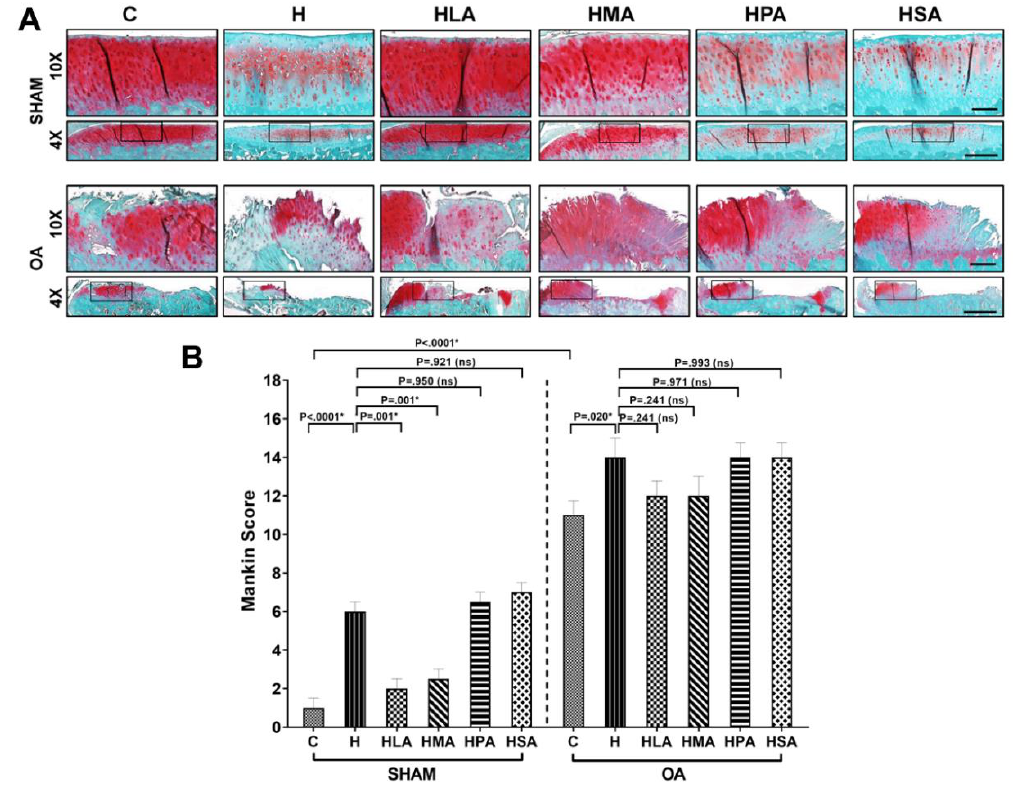
Figure 4. Histological evaluation of the knee joints. Pictures were obtained under 4× and 20× magnifications representing the medial tibial plateau. ( A ) Sections of articular cartilage stained with Safranin O/Fast Green shows the extent of proteoglycan loss among the different diet groups in both sham and osteoarthritic (OA) rats. (B) The severity of articular cartilage degradation was graded using Mankin scoring system in both sham and OA rats. All values are represented as mean ± SD, n = 6. C, corn starch diet-fed rats; H, high-carbohydrate high-fat diet-fed rats; HLA, high-carbohydrate high-lauric acid diet-fed rats; HMA, high-carbohydrate high-myristic acid diet-fed rats; HPA, high-carbohydrate high-palmitic acid diet-fed rats; HSA, high-carbohydrate high-stearic acid diet-fed rats.